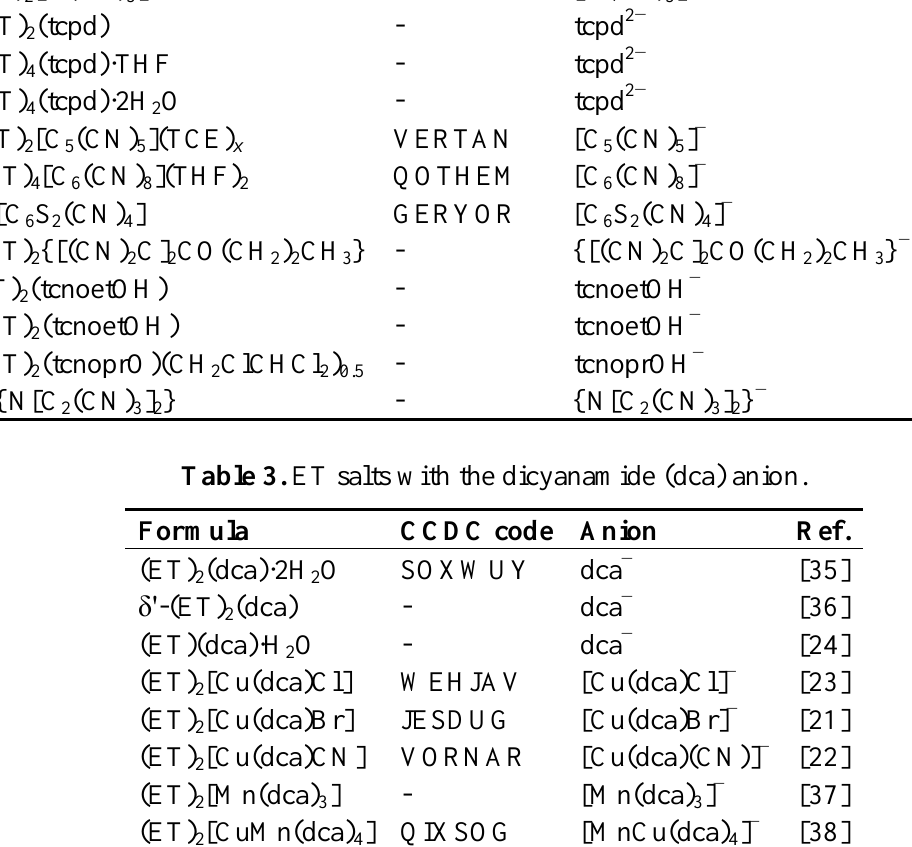
TCNQ), (ET)(ClMeTCNQ) [25], (ET)(F-TCNQ), (ET)(F 2